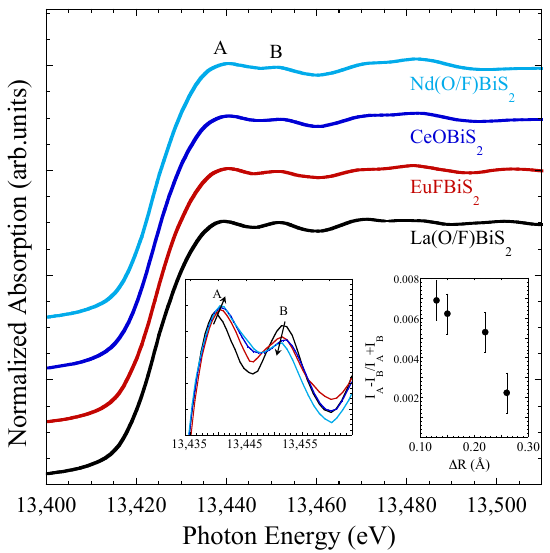
Figure 4. X-ray absorption near edge structure (XANES) spectra of RE(O/F)BiS 2 single crystals measured at the Bi L 3 -edge. The nearest edge features are denoted by A and B. The left inset shows a zoom-over the features A and B. The right inset shows normalized intensity difference plotted as a function of the distortion amplitude in the BiS 2 -layer. The error bars represent maximum uncertainty estimated by analyzing different scans for each